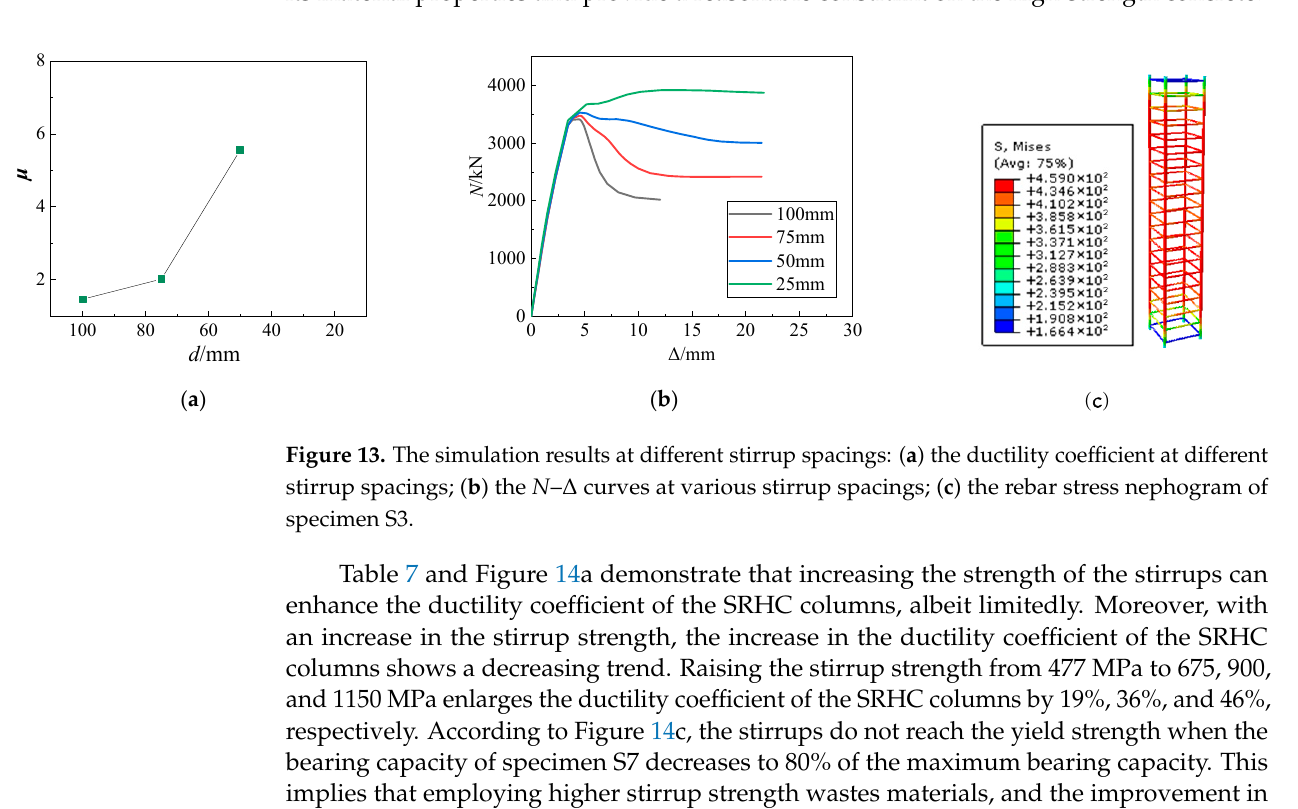
Table 7. Comparing the calculation results of various codes with the test